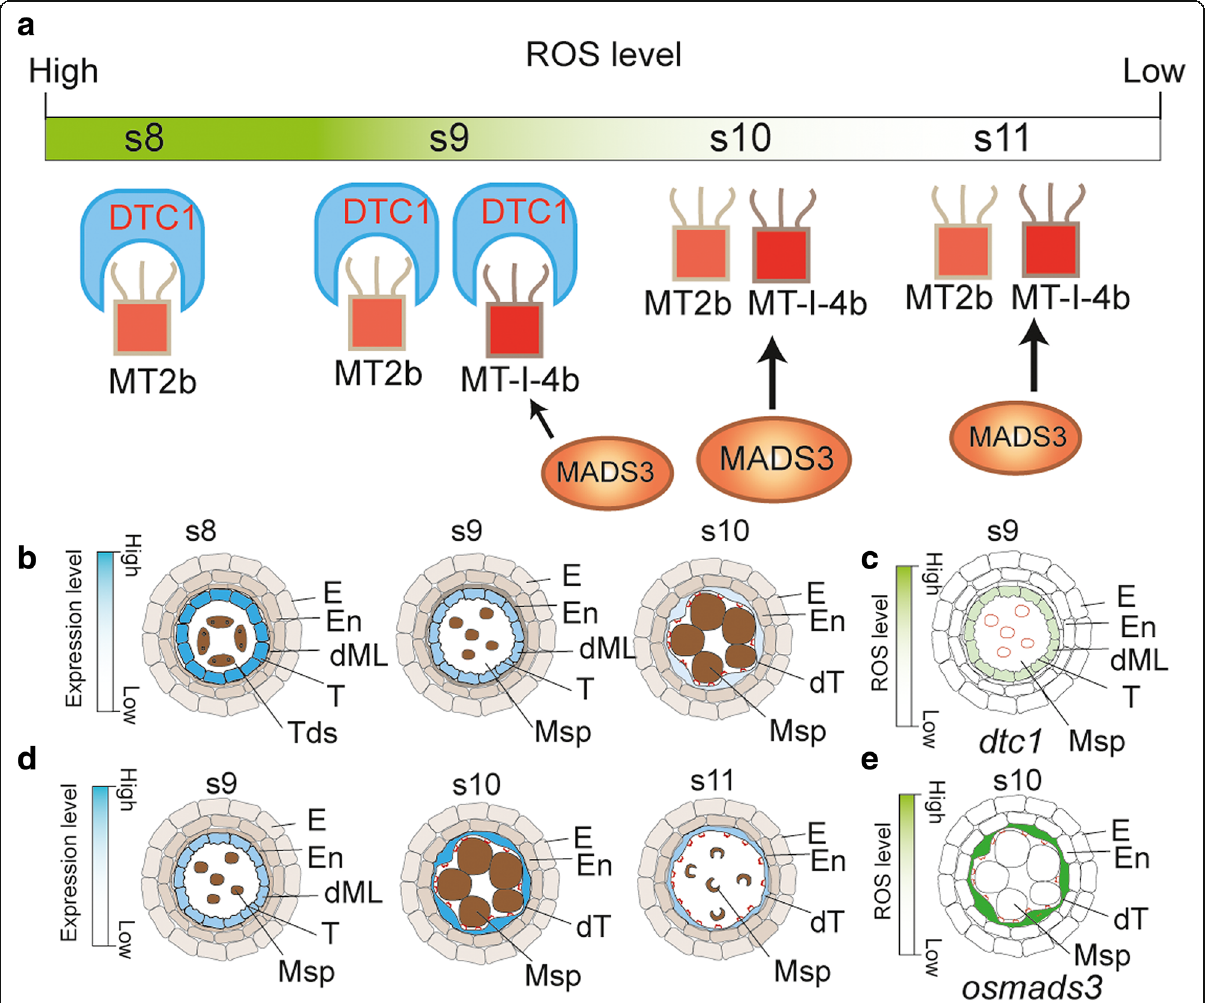
Fig. 5 ROS scavengers and the regulatory network during tapetal PCD. a DTC1 and OsMADS3 control ROS level via regulating MT2b and MT-I-4b, b Expression pattern of DTC1 in anther, c Phenotype of dtc1 anther at stage 9, d Expression pattern of OsMADS3 in anther, e Phenotype of osmads3 anther at stage 10. Blue color in b and d shows the gradients of gene expression; grey color in b and d show s different cell layers without the expression of DTC1 ( b ) and OsMADS3 ( d ); green color in c and e shows the gradient of ROS level; white color in c and e shows undetectable level of ROS by DAB